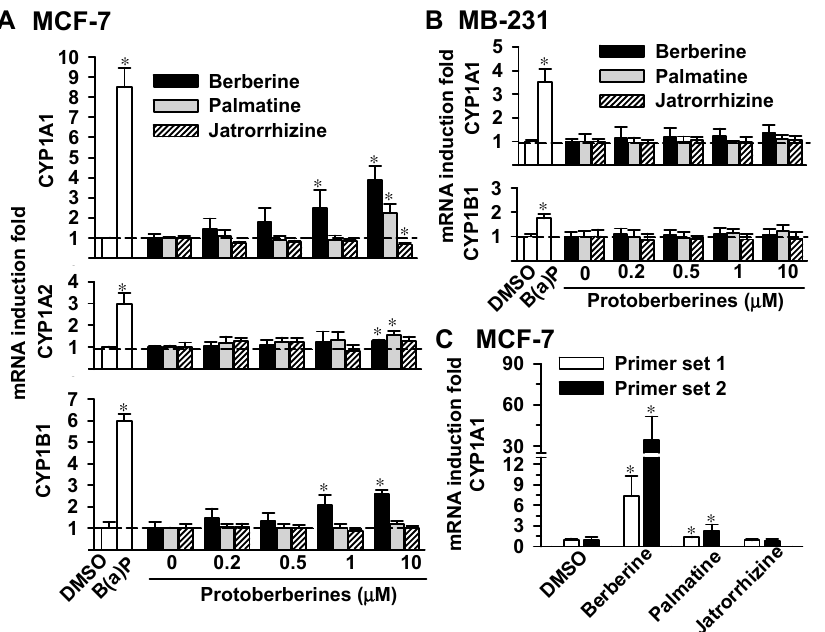
Figure 2. Effects of the protoberberines on the mRNA levels of CYP1A1, CYP1A2 and CYP1B1 in MCF-7 ( A , C ) and MB-231 ( B ) cells. Cells were exposed to B(a)P (2 μ M) and protoberberines for 24 h. Total cellular RNA was isolated and subjected to reverse transcriptional reaction. In panels ( A , B ), the cDNA was subjected to PCR using the primer sets as described in the Materials and Methods. The PCR product was analyzed using gel electrophoresis and relative band intensity was determined. Results show the induction fold of the CYP1 mRNA level normalized by the mRNA level of β -actin. In panel ( C ), CYP1A1 mRNA level was determined using real-time PCR analysis and two primer sets were used as described in the Materials and Methods. Results show the induction fold of the CYP1A1 mRNA level normalized by the mRNA level of GAPDH. Data represent the mean ± SD of 3 separate experiments. * p < 0.05, compared with the control